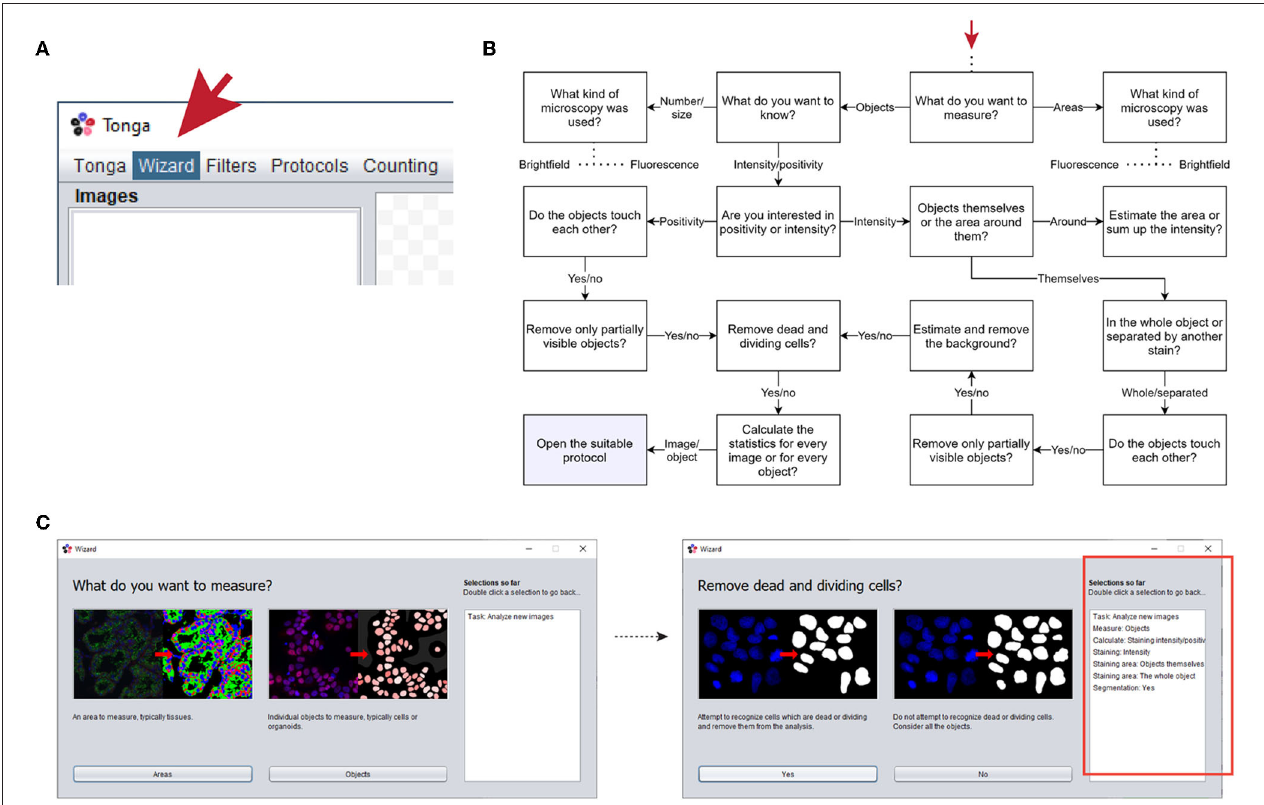
FIGURE 2 | Overview of the wizard feature. (A) Wizard can be found and launched from the menu bar. (B) Example of one branch of the wizard decision tree, starting point indicated by red arrow. (C) Examples of the wizard window helping to select suitable protocol to use. Selections for the analysis made by the user are listed in the box on the right (highlighted with red box in the right